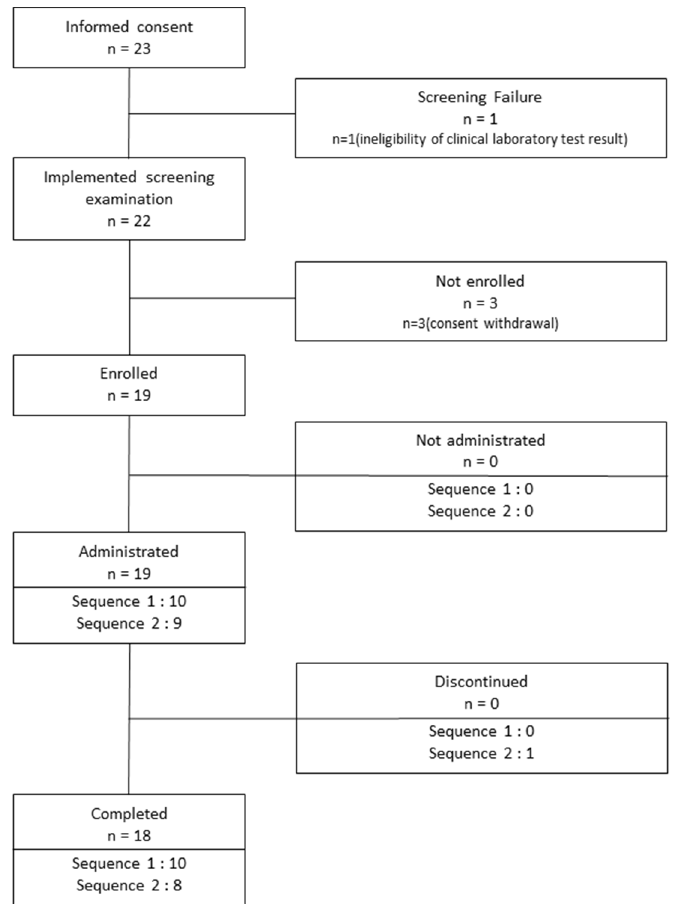
Figure 3. Flowchart showing subject disposition.